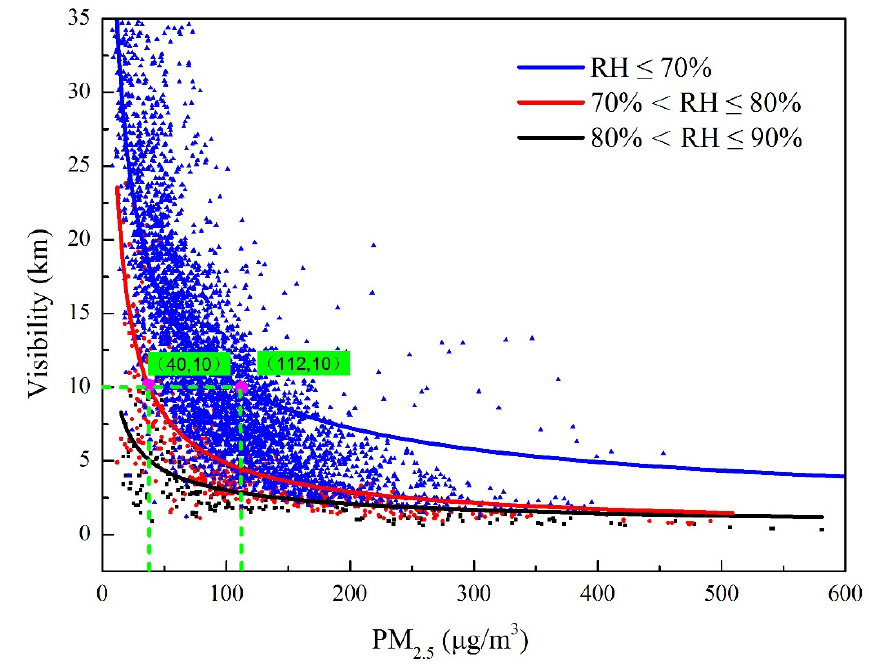
Figure 1. Variation in visibility with PM 2.5 in different RH conditions in Tianjin, 2015. Data points are colored to represent relative humidity (RH ≤ 70%, 70% < RH ≤ 80%, 80% < RH ≤ 90%); data (40 µg/m 3 , 10 km) and (112 µg/m 3 , 10 km) are the thresholds of PM 2.5 (40 and 112 µg/m 3 ) corresponding to the visibility of 10 km under the conditions of 70% < RH ≤ 80% and RH ≤